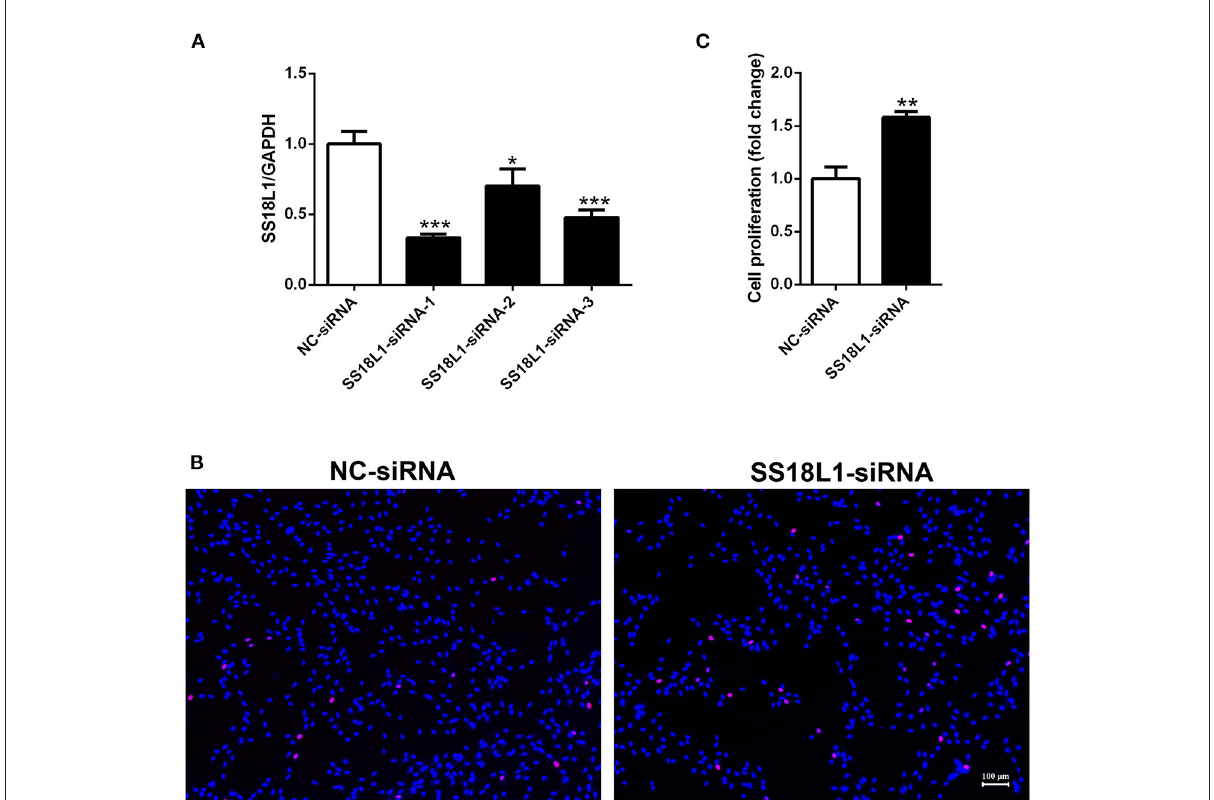
FIGURE3 The effect of SS18L1 on Schwann cell proliferation. (A) Relative mRNA expression of SS18L1 in Schwann cells transfected with SS18L1 siRNAs or siRNA control (NC-siRNA). * P < 0.05, vs. siRNA control, *** P < 0.001, vs. siRNA control. (B) Representative images and histogram of the proliferation of Schwann cells transfected with SS18L1 siRNA or siRNA control. Red color indicates Schwann cells stained with EdU and blue color indicates Schwann cells stained with Hoechst 33342. Scale bars indicated 100 µ m. (C) Summarized histogram of the proliferation of Schwann cells transfected with SS18L1 siRNA or siRNA control. ** P < 0.01, vs. siRNA control.